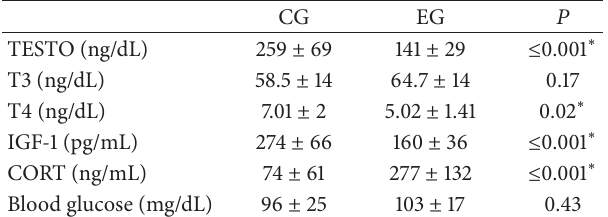
Table 1: Hormonal profile between control rats and sleep-deprived rats.